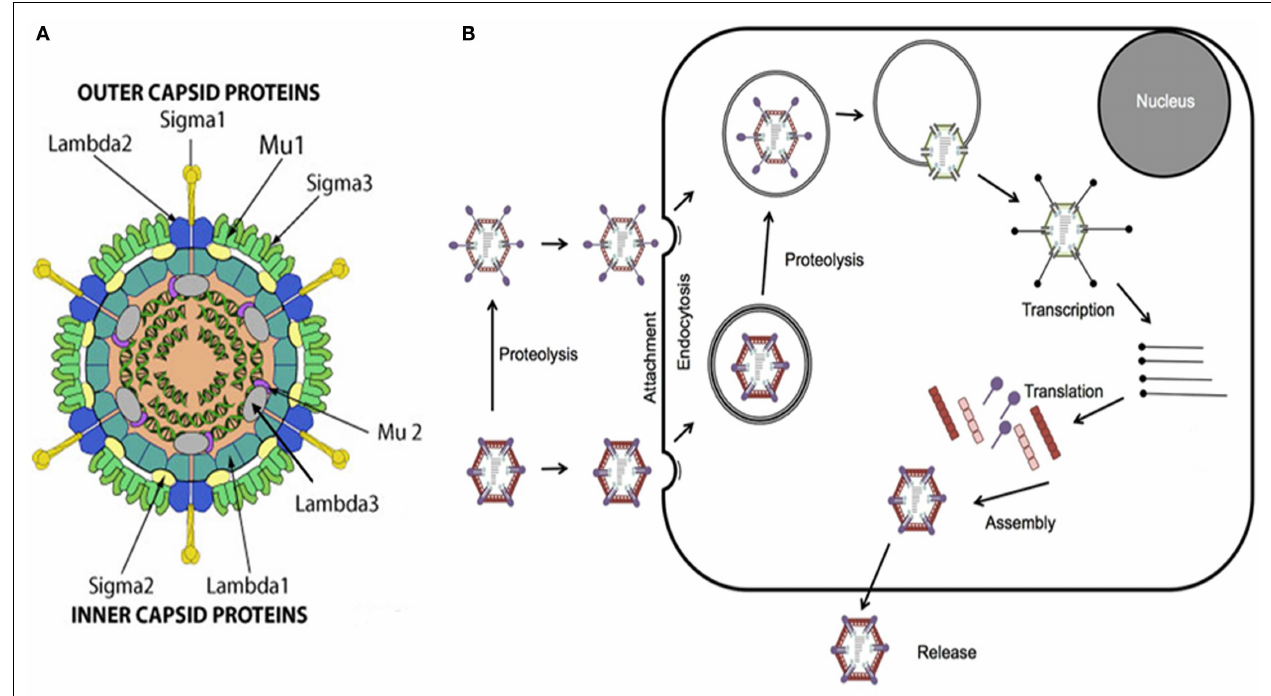
FIGURE 1 | Reovirus structure and infectious cycle . (A) Reovirus is a non-enveloped double-stranded RNA (dsRNA) virus approximately 80nm in diameter.The viral genome, consisting of 10 segments of dsRNA, is contained within an outer and inner capsid and encodes for structural proteins comprising the outer capsid including sigma 1 ( σ 1), sigma 3 ( σ 3), lambda 2 ( λ 2), and mu 1 ( µ 1), structural proteins comprising the inner capsid including sigma 2 ( σ 2), lambda 1 ( λ 1), lambda 3 ( λ 3), and mu 2 ( µ 2), and non-structural proteins including sigma 1s ( σ 1s), sigma NS ( σ NS),